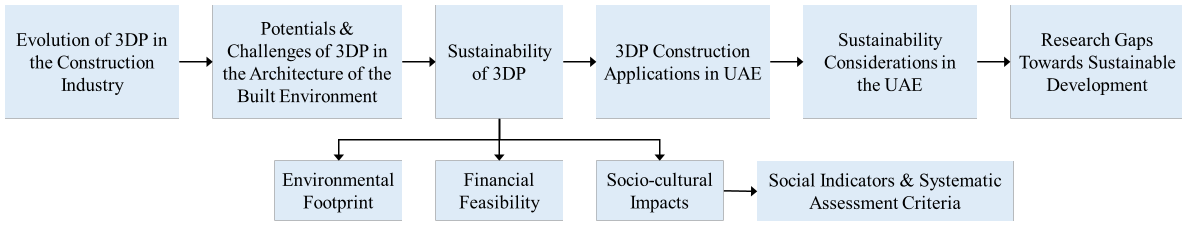
Figure 4. Schematic diagram of the research framework.